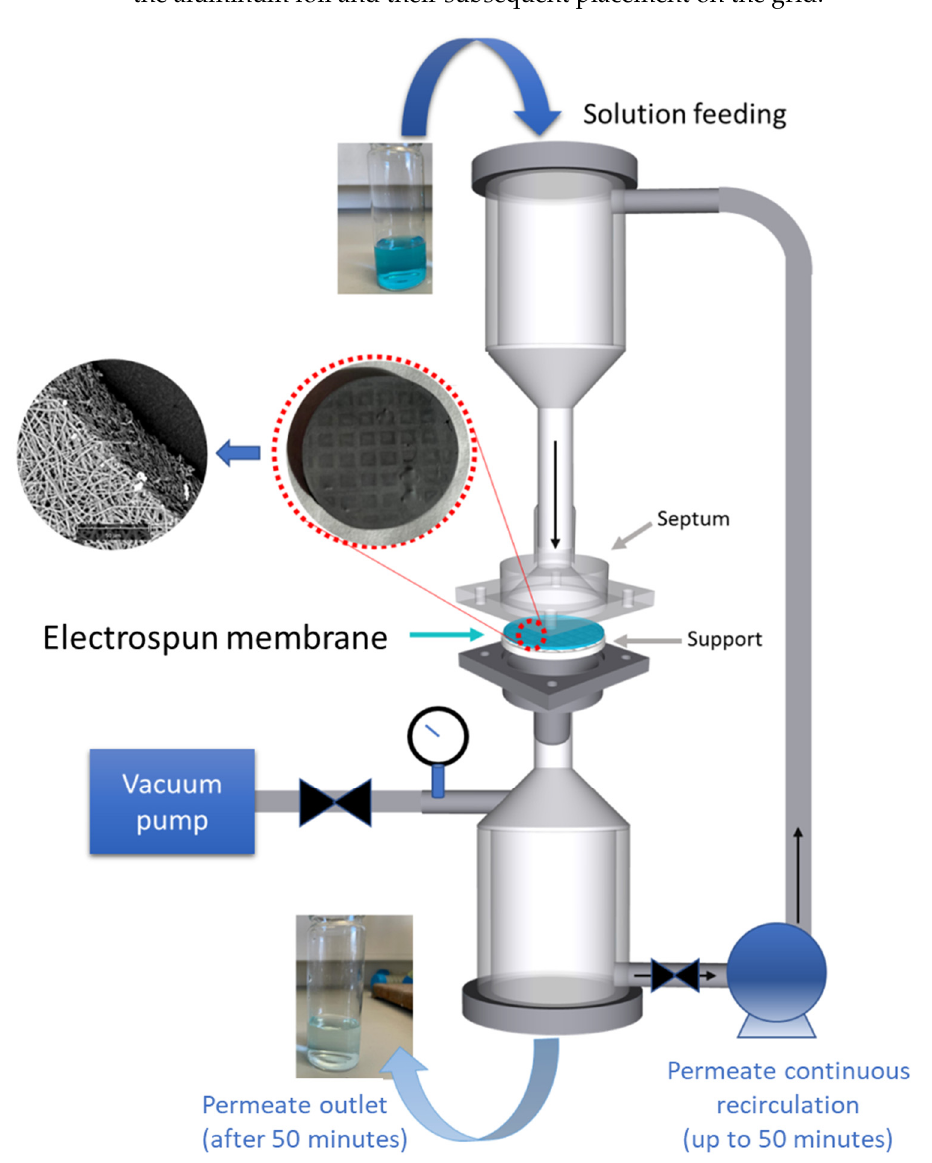
Figure 1. Schematics of the experimental setup and the device used, along with digital and SEM photographs of a membrane.